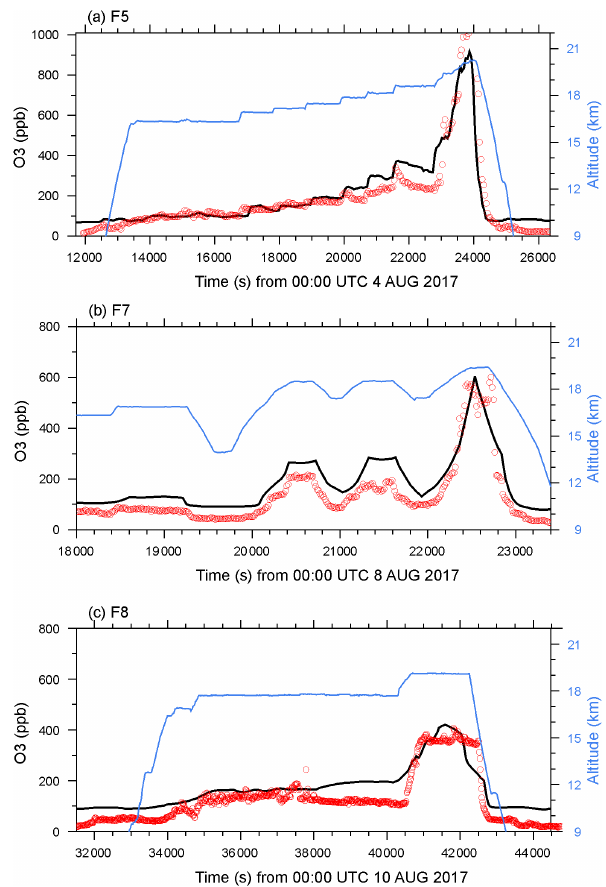
Figure 5. Comparison of measured (red circles) and Meso-NH- derived (black lines) ozone (ppb) along the StratoClim flight tracks (a) #5 on 4 August, (b) #7 on 8 August, and (c) #8 on 10 August 2017 (for the locations, see Fig. 1). Flight altitudes are displayed by light blue